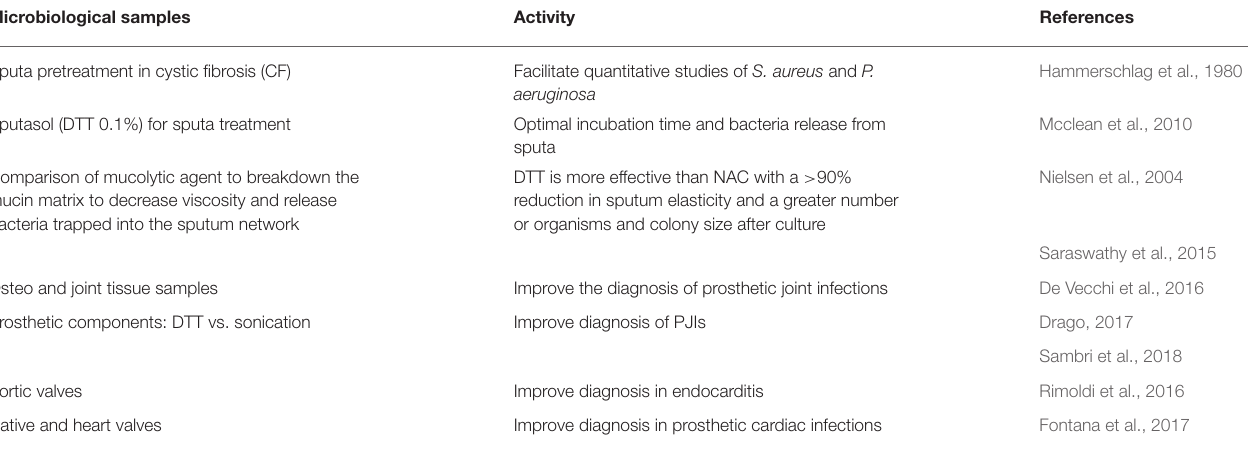
TABLE 1 | Clinical use of DTT pretreatment to dislodge microorganisms in biological